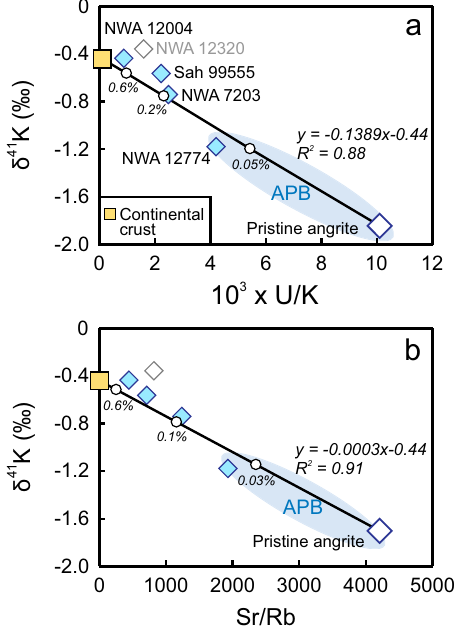
Fig. 3 | Negative correlations of δ 41 K values with U/K ratios and Sr/Rb ratios. The coherent correlations in a and b most likely re fl ect contamination of the pristine angrite composition (low in δ 41 K, K, and Rb) by a crustal component with higher δ 41 K, K, and Rb. The yellow square denotes the average composition of the uppercontinentalcrust,with2.8wt%K 2 Oand84ppmRb(ref.49),anda δ 41 Kvalue of − 0.44±0.05 ‰ (ref. 50.). The δ 41 K value of pristine angrite is extrapolated from the linear regression of measured angrites and upper continental crust, and is shownbytheopendiamondsymbolwithdarkblueborder.Theblue fi eldsindicate the δ 41 K range inferred for the angrite parent body (APB). The numbers along the binary mixing lines in black indicate the fraction of crustal contamination. Sample NWA 12320, shown by an open symbol with grey border, is not included in the linear regression as it is likely unrepresentative of the bulk composition of this angriteduetothepresenceofsecondarybaritesformedduringaqueousalteration. Please refer to Supplementary Fig. 5 for more detailed discussions. δ 41 K error bars (95% c.i.) are smaller than the sample